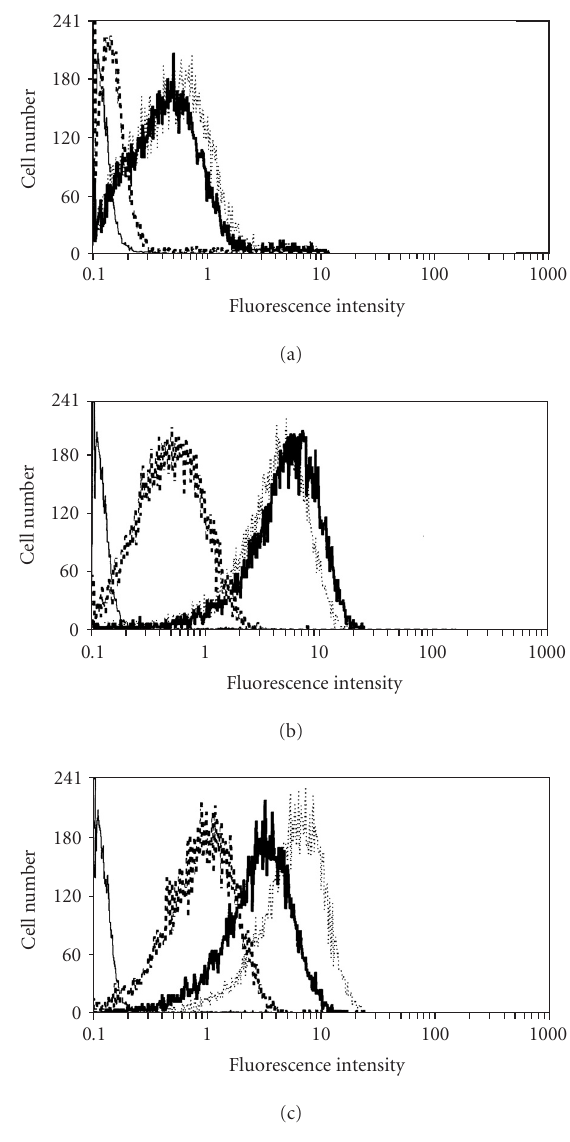
Figure 7. Binding of S100A8/A9 complex to MM46 cells which were treated with trypsin or heparinase. Untreated MM46 cells (thin dotted line) or cells treated with trypsin (bold dotted line), or heparinase (bold line) were incubated with 5 µ M S100A8/A9 in the defined divalent cation medium (a), in the standard medium (b), or in the standard medium with 20 µ M zinc sul- fate (c) for 1h, respectively. The histograms of the control cells which were incubated without any sample for 1 h in the respec- tive medium are represented by a narrow solid line (solid line). The amount of S100A8/A9 bound to the cells was measured as described in “materials and